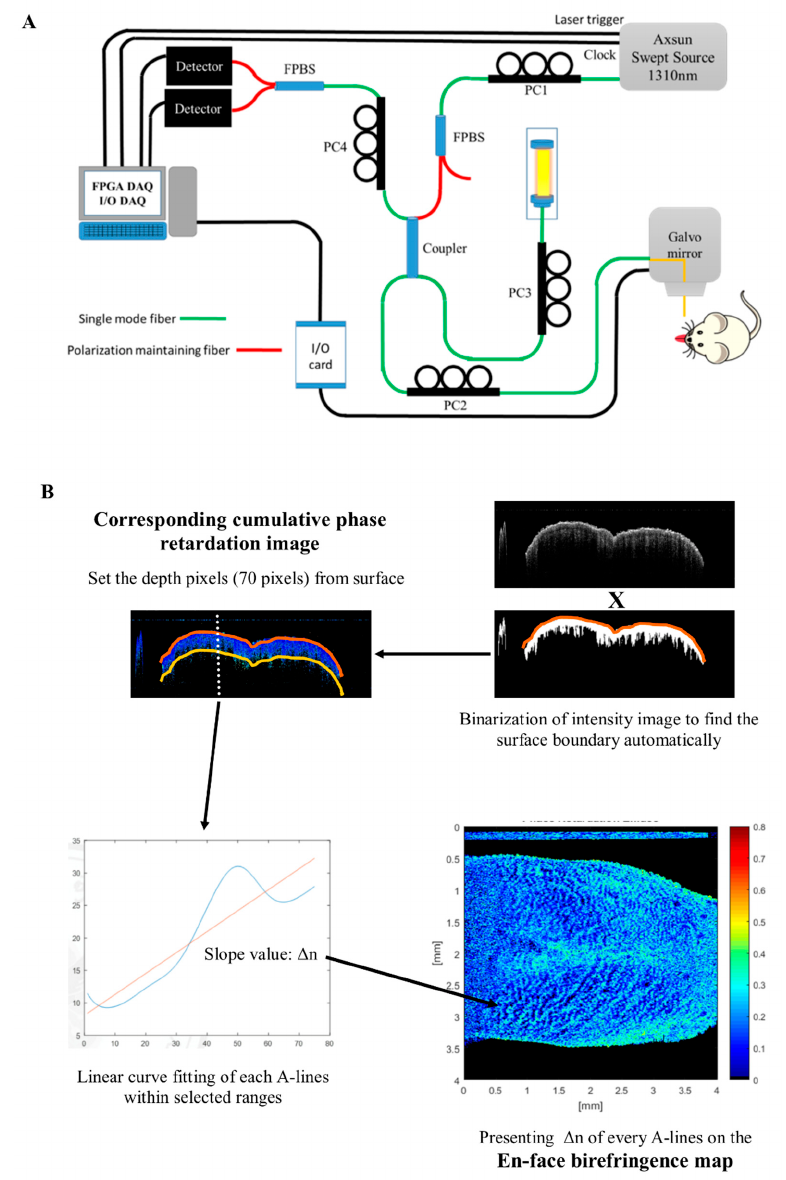
Figure 6. ( A ) Setup of the swept-source, polarization-sensitive optical coherence tomography (SS PS-OCT) imaging system (PC: polarization controller; FPBS: fiber polarization beam splitter). ( B ) Process of the en-face birefringence map: a gray-level thresholding algorithm was used to binarize the intensity image and find out the upper border of the surface automatically. After determining the surface, the fixed depth (70 pixels, about 410 μ m) was set to the corresponding cumulative phase retardation image. Then, linear curve fitting was performed between the surface and selected depth to each A-lines. The slope value ( Δ n ) of each A-line was presented in an en-face birefringence map. (4 × 4 mm in the x – y plane).